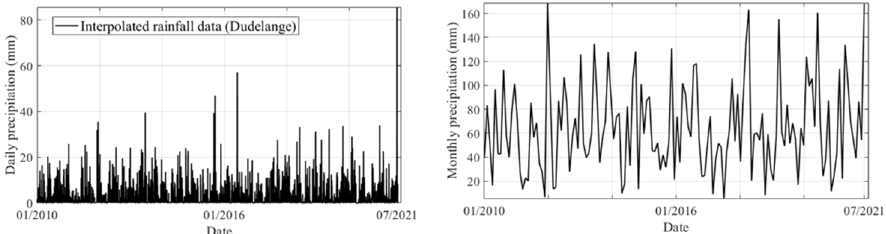
Figure 10. Estimated rainfall for Dudelange (ungauged). ( Left ) panel: daily, ( Right ) panel: monthly rainfall data.